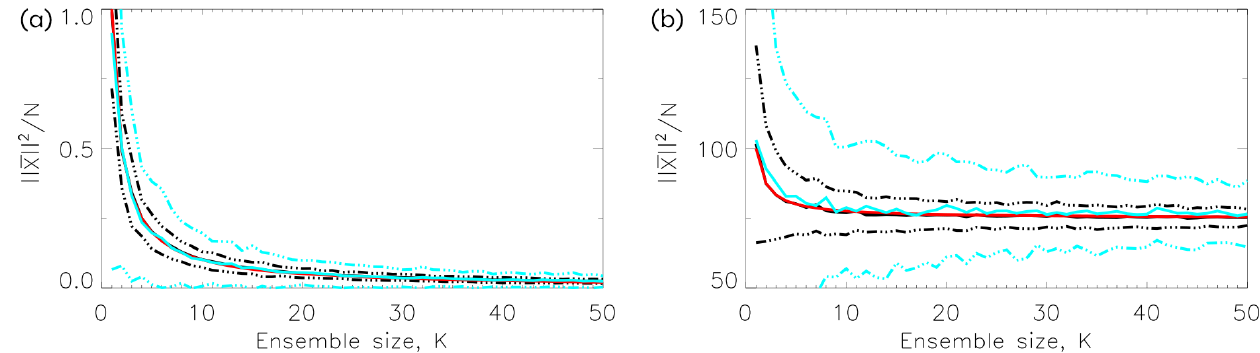
Figure 8. The length of the sample mean || x || 2 /N as a function of sample size K . Black curves show results from N = 100 and blue curves for N = 10. For each K results are based on 200 draws. The solid curves show the mean over these draws and the broken curves the mean ± 2 standard deviations. The red curve is an analytic result (Eq. 12) with the theoretical values for µ and σ . In (a) each component of the vectors is drawn from a standard Gaussian µ 2 = 0, σ 2 = 1; in (b) each component is drawn from a Gamma distribution, µ 2 = 75 . 00, σ 2 = 25 . 00 (see caption to Fig.